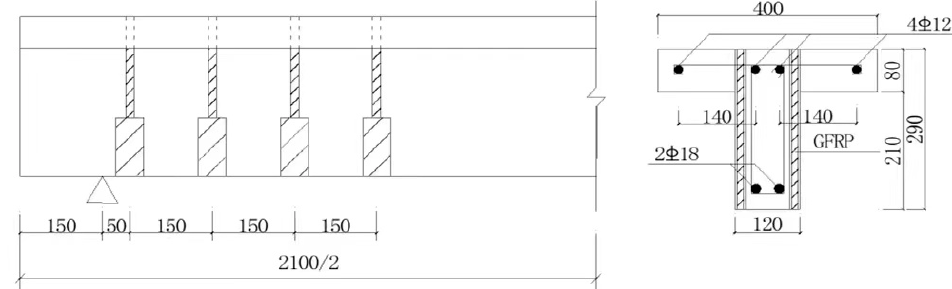
Figure 4. Reinforced specimen cross-section dimensions and reinforcement.